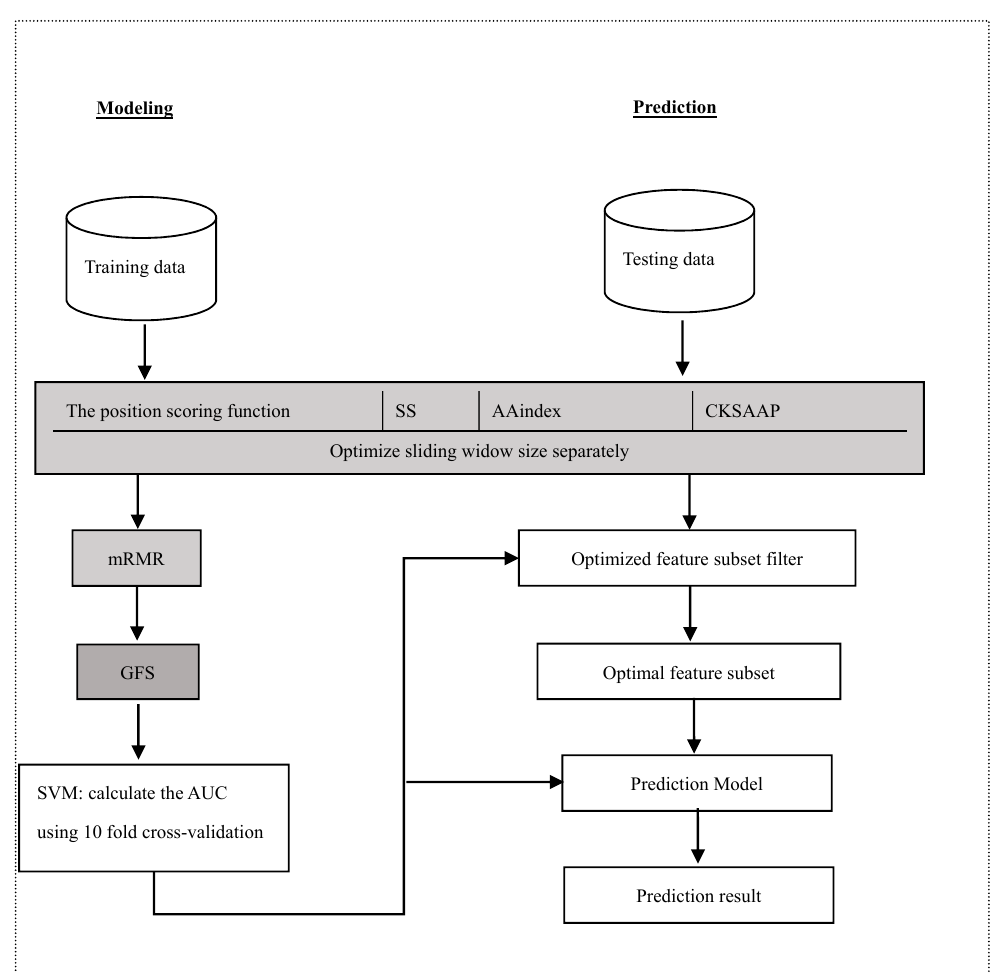
Figure 1. System architectures of the proposed method.